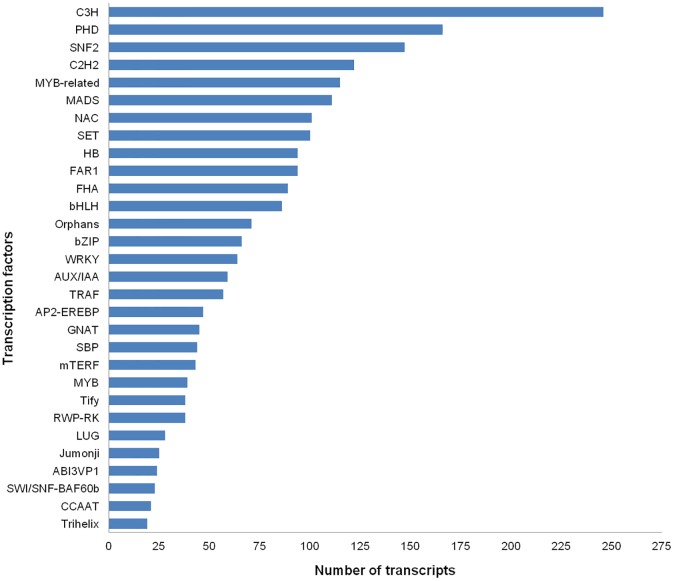
Transcription factor families identified in the Rafflesia cantleyi flower transcriptome.